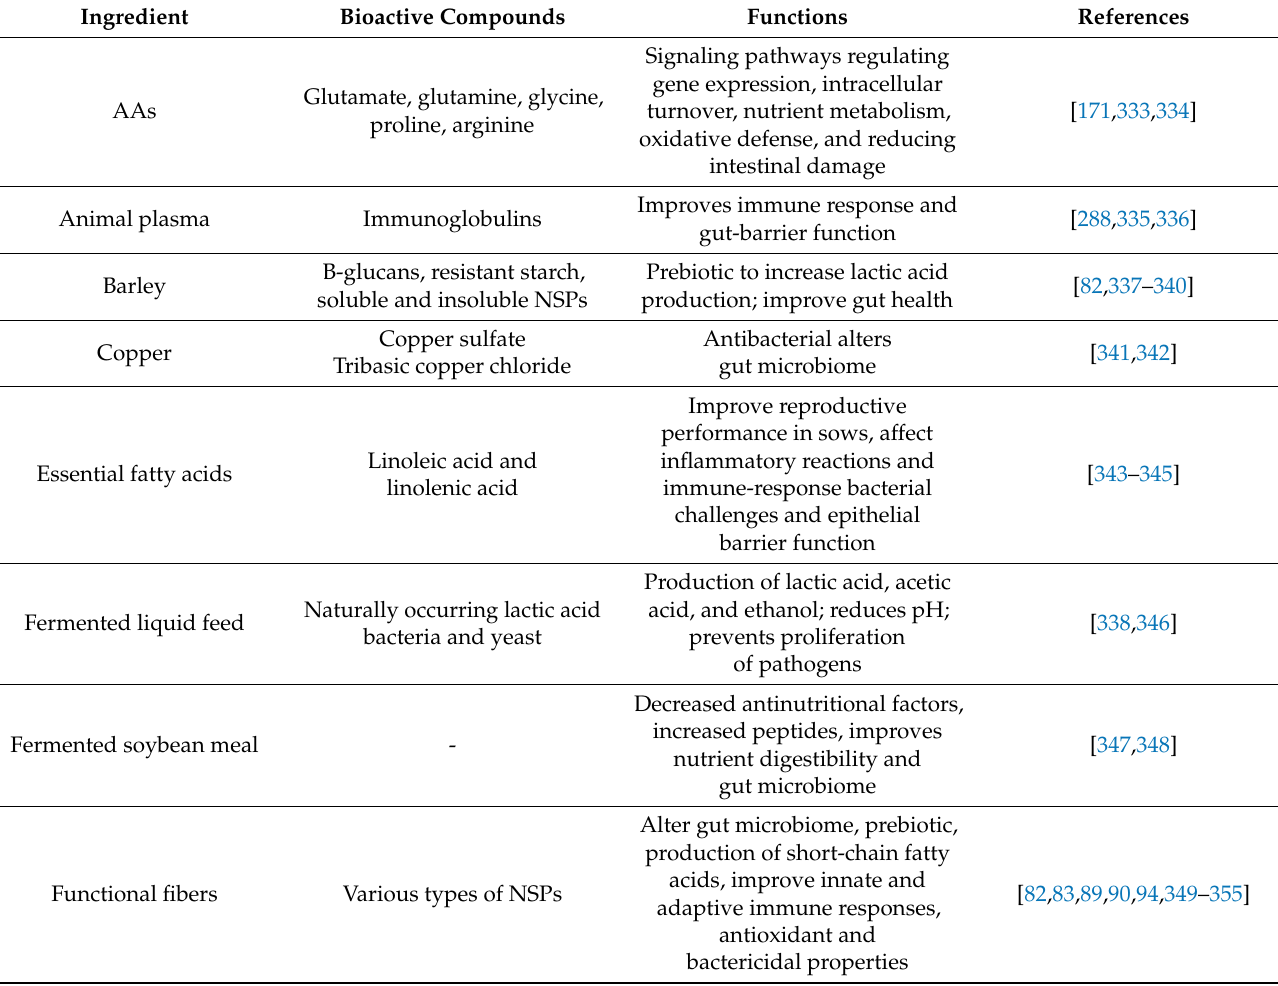
Table 14. Summary of functional ingredients, nutrients, bioactive compounds, and functions associated with improvements in swine